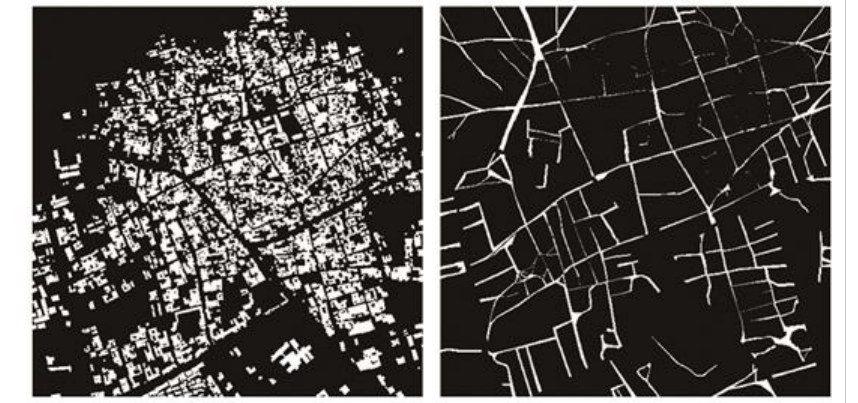
Fig.3. Preprocessing of input